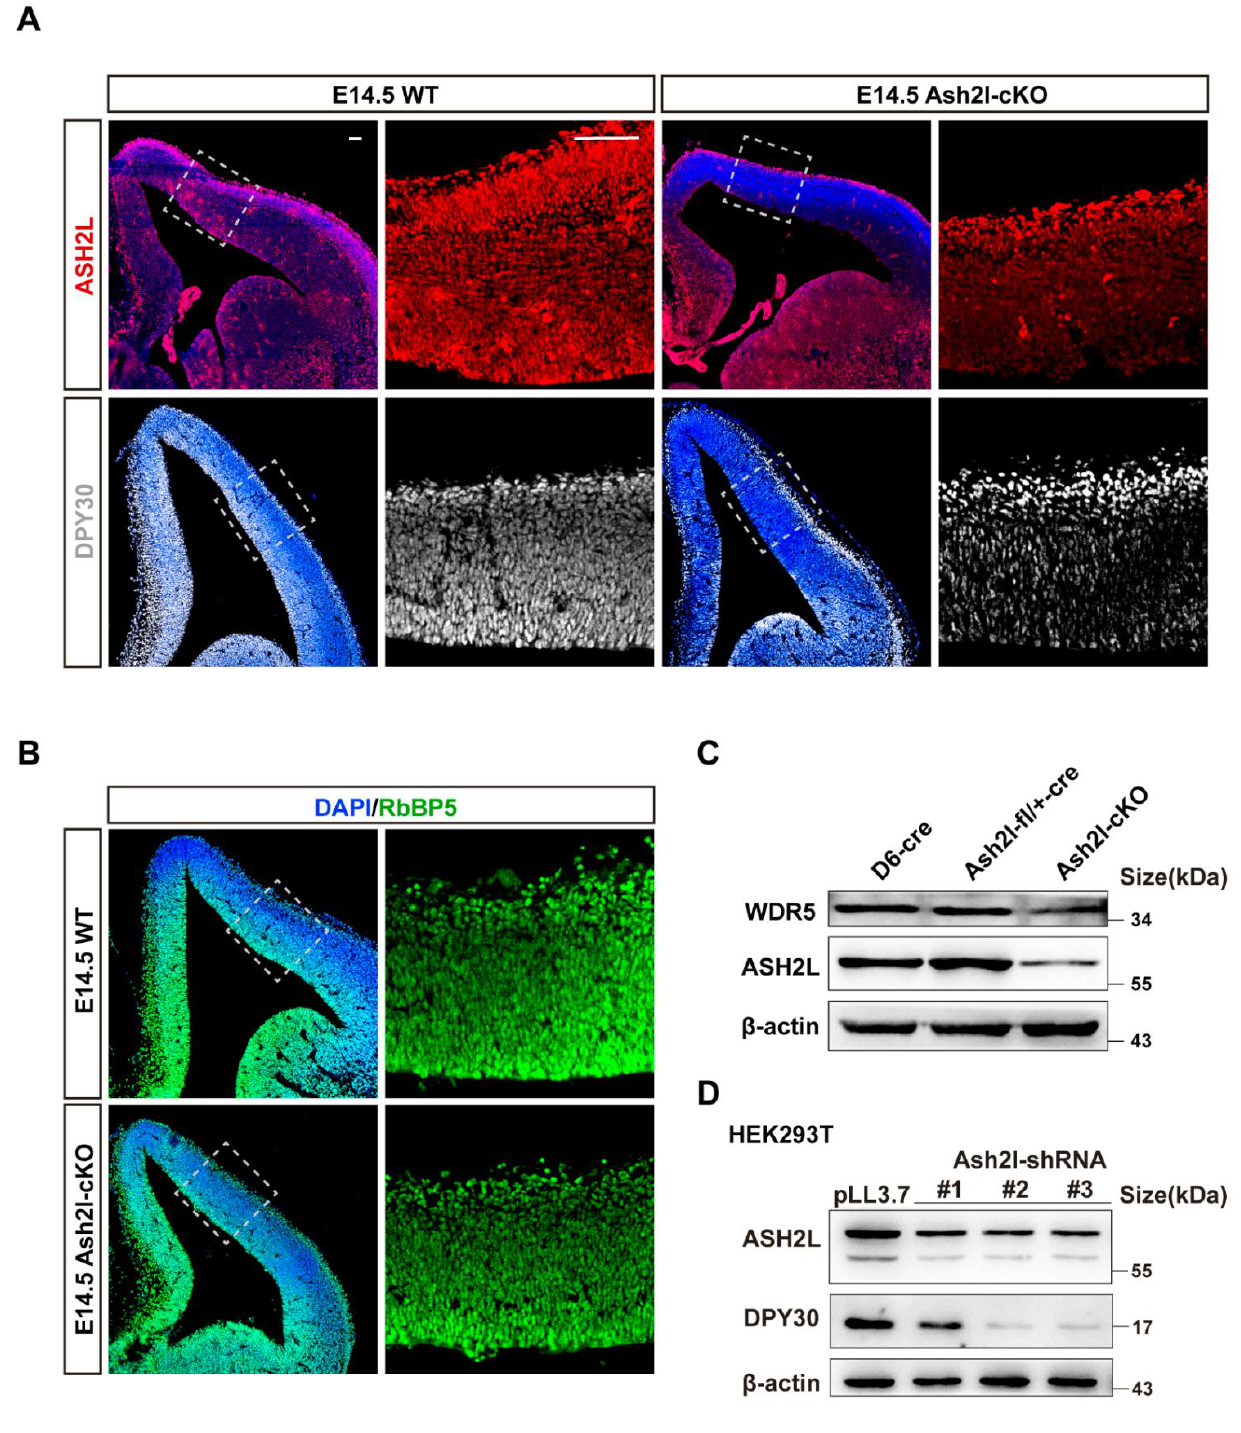
Figure 1. Ash2l is crucial for the expression of DPY30 both in vivo and in vitro. ( A ) Immunofluores- cence of ASH2L and DPY30 in the E14.5 dorsal cortex. Scale bars = 100 μm. ( B ) Immunofluorescence of RbBP5 in the E14.5 dorsal neocortex. ( C ) Western blot to detect the expression of ASH2L and WDR5 in the E14.5 neocortex. ( D ) Detection of DPY30 and ASH2L in HEK293T cells transfected with Ash2l-shRNAs, harvested 72 h after transfection. ( C , D ) were biologically repeated three times. Theoretically, the decrease in DPY30 can result from reduced transcription and trans- lation or degradation of mRNA and protein. First, we inspected the ChIP-seq data of H3K4me3 and ASH2L. Although there was direct binding of ASH2L and H3K4me3 at Dpy30 loci, we did not find significant changes in the H3K4me3 peak at the Dpy30 loci,